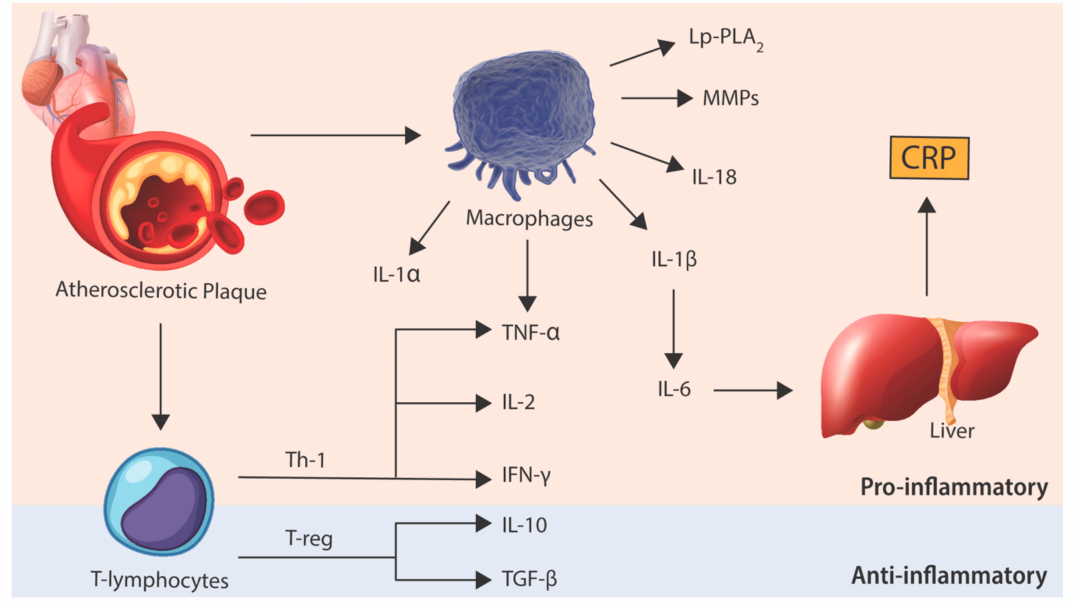
Figure 2. Inflammatory pathways involved in atherosclerosis. Data from preclinical and clinical trials suggest an intricate balance between pro-inflammatory and anti-inflammatory pathways. It is this balance that determines the development and progression of atherosclerotic plaque that may result in the thrombotic complications associated with plaque rupture. CRP, C-reactive protein; MMPs, matrix metalloproteinases; IFN- γ , interferon-gamma; IL-1 α , interleukin-1-alpha; IL-1 β , interleukin-1-beta; IL-2, interleukin-2; IL-6, interleukin-6; IL-10, interleukin-10; IL-18, interleukin-18; Lp-PLA 2 , lipoprotein-associated phospholipase A2; TGF- β , transforming growth factor beta; Th-1, T-helper-1 lymphocyte; TNF- α , tumor necrosis factor alpha; T-reg, regulatory T